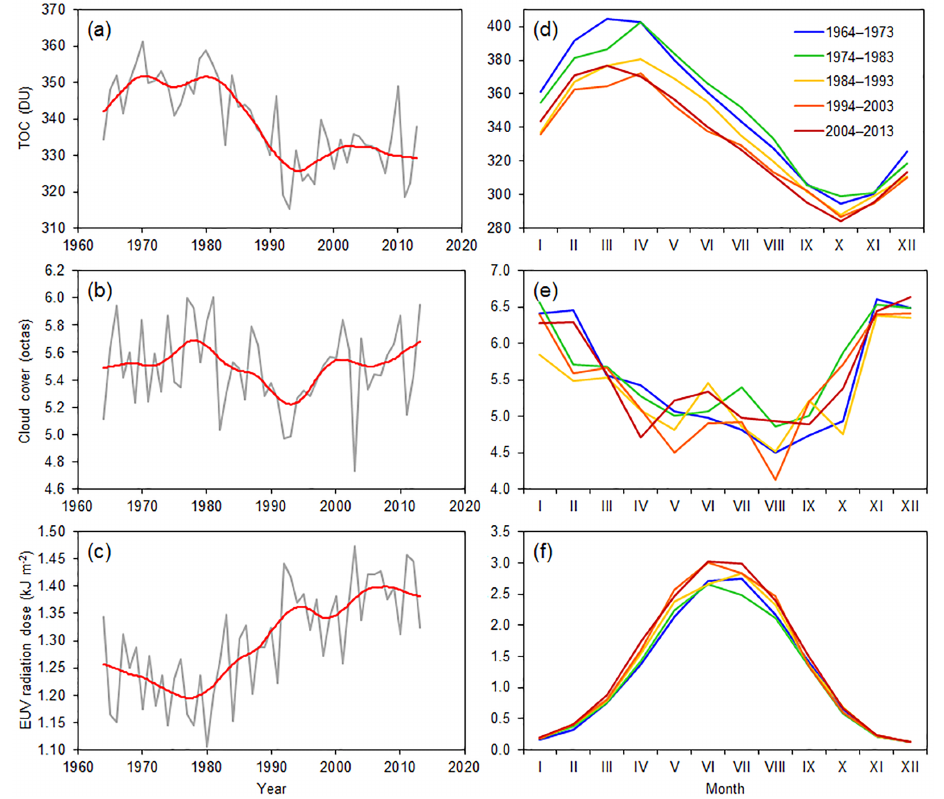
Figure 2. The annual means of (a) TOC, (b) cloud cover, and (c) daily EUV radiation doses fitted with the locally weighted scatterplot smoothing curve (red), and the mean annual variation of (d) TOC, (e) cloud cover, and (f) daily EUV radiation doses at the Hradec Králové observatory in the individual decades of the period